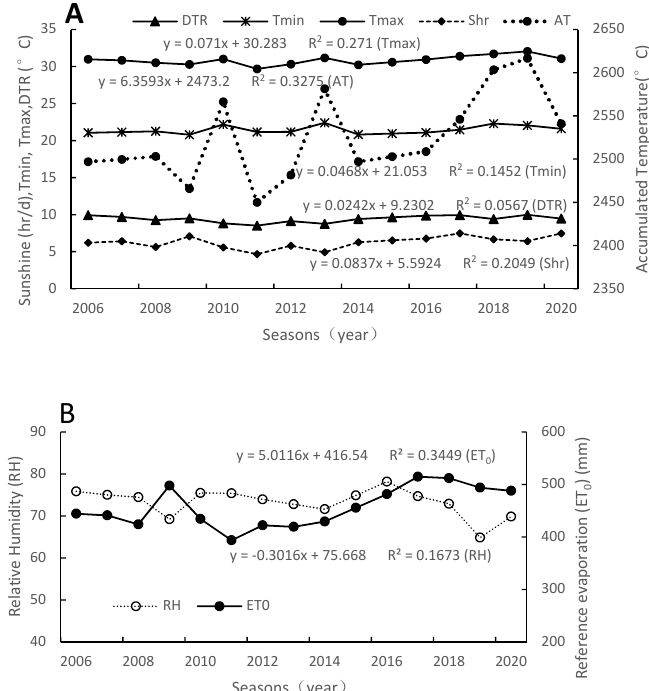
Figure 2. Changes in weather factors during the 5 growing seasons of foxtail millet and the recent 15 years from 2006 to 2020 (Sunshine: sunshine duration; Tmax: maximum temperature; Tmin: minimum temperature; accumulated temperature; DTR: average daily diurnal temperature range; ( A ). RH: relative humidity; ET 0 : reference evaporation ( B )).